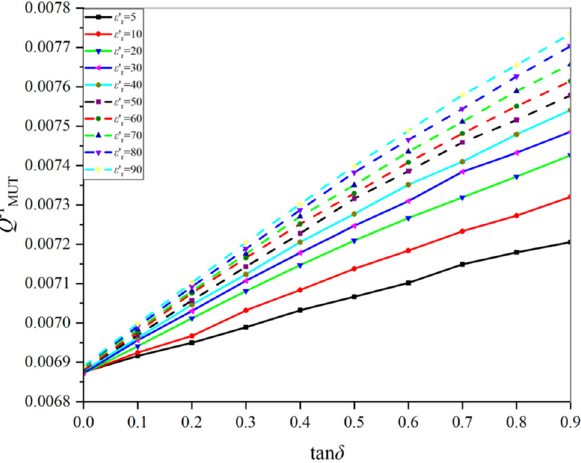
Figure 9. The relationship between r